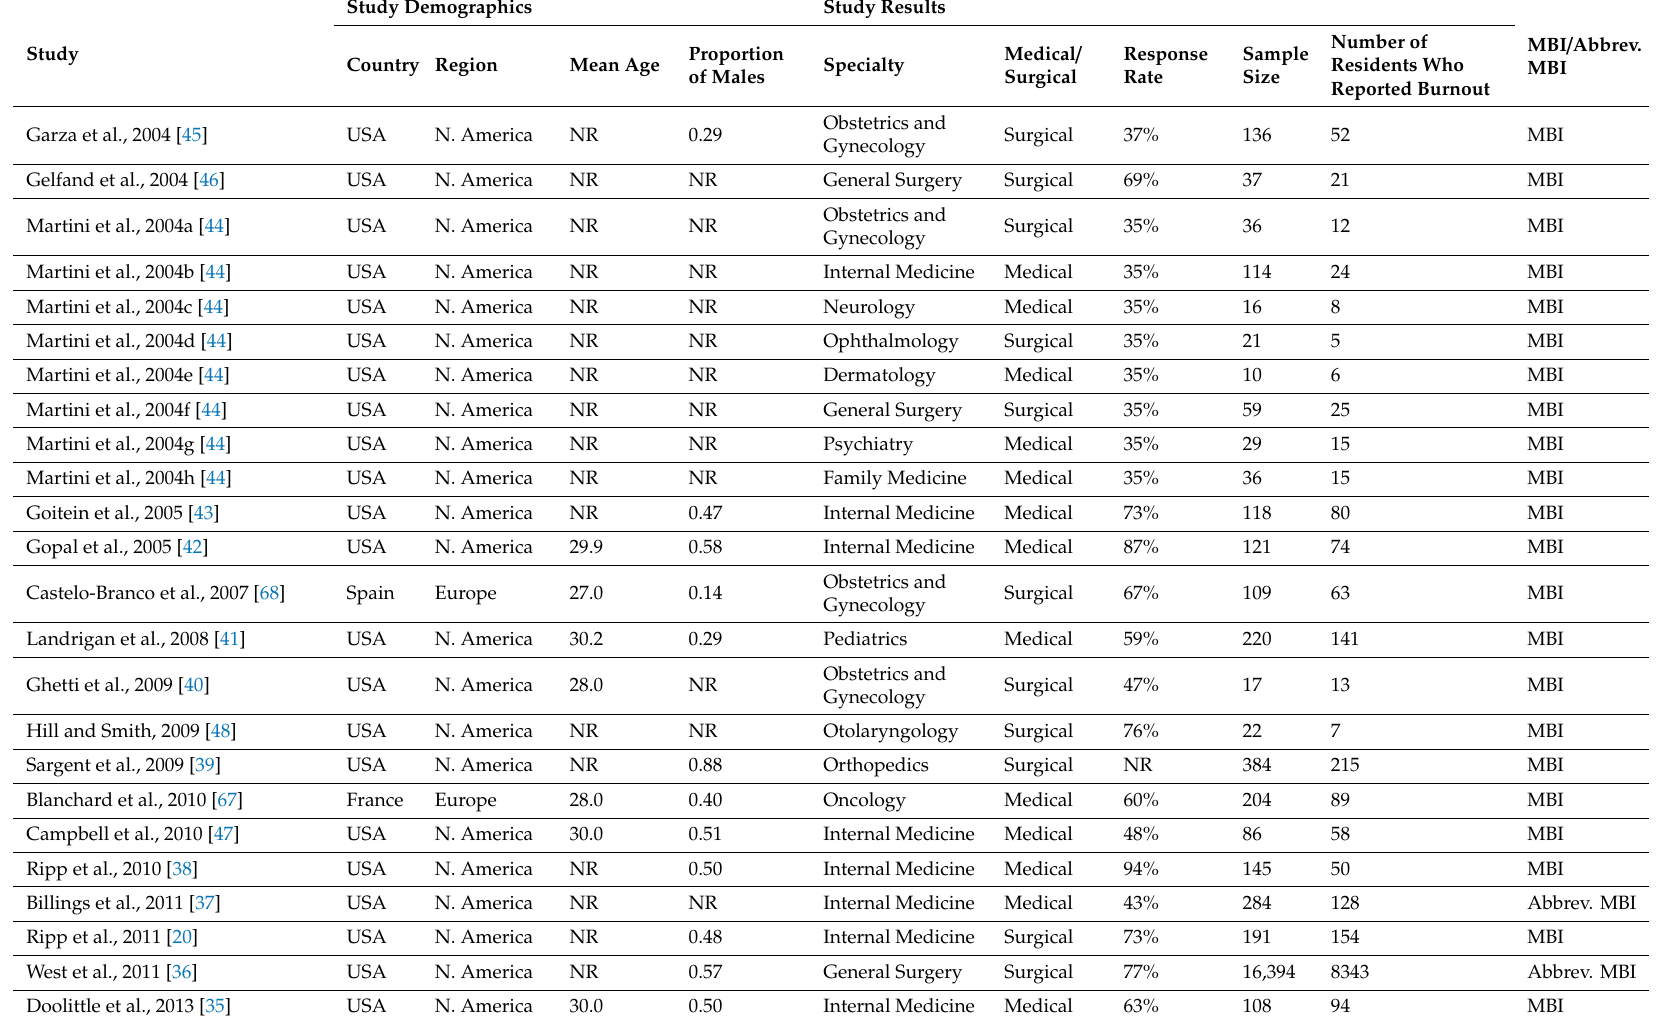
Table 1. Characteristics of included